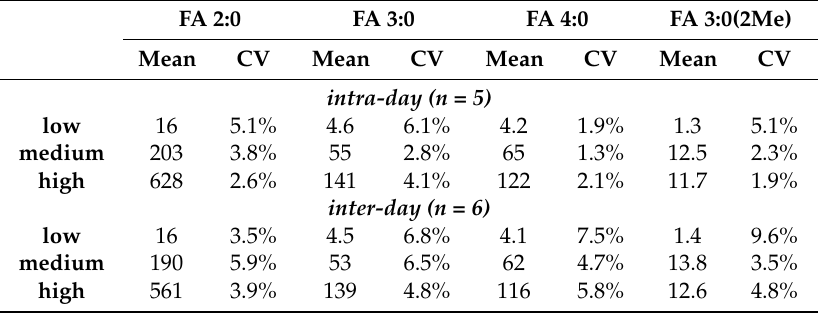
Table 2. Precision of SCFA–3NPH quantification. Displayed are within-run ( n = 5) and between-run ( n = 6) coefficients of variations (CVs) for fecal samples with low, medium, and high SCFA concentrations. Mean concentrations are in µ mol/g dry weight